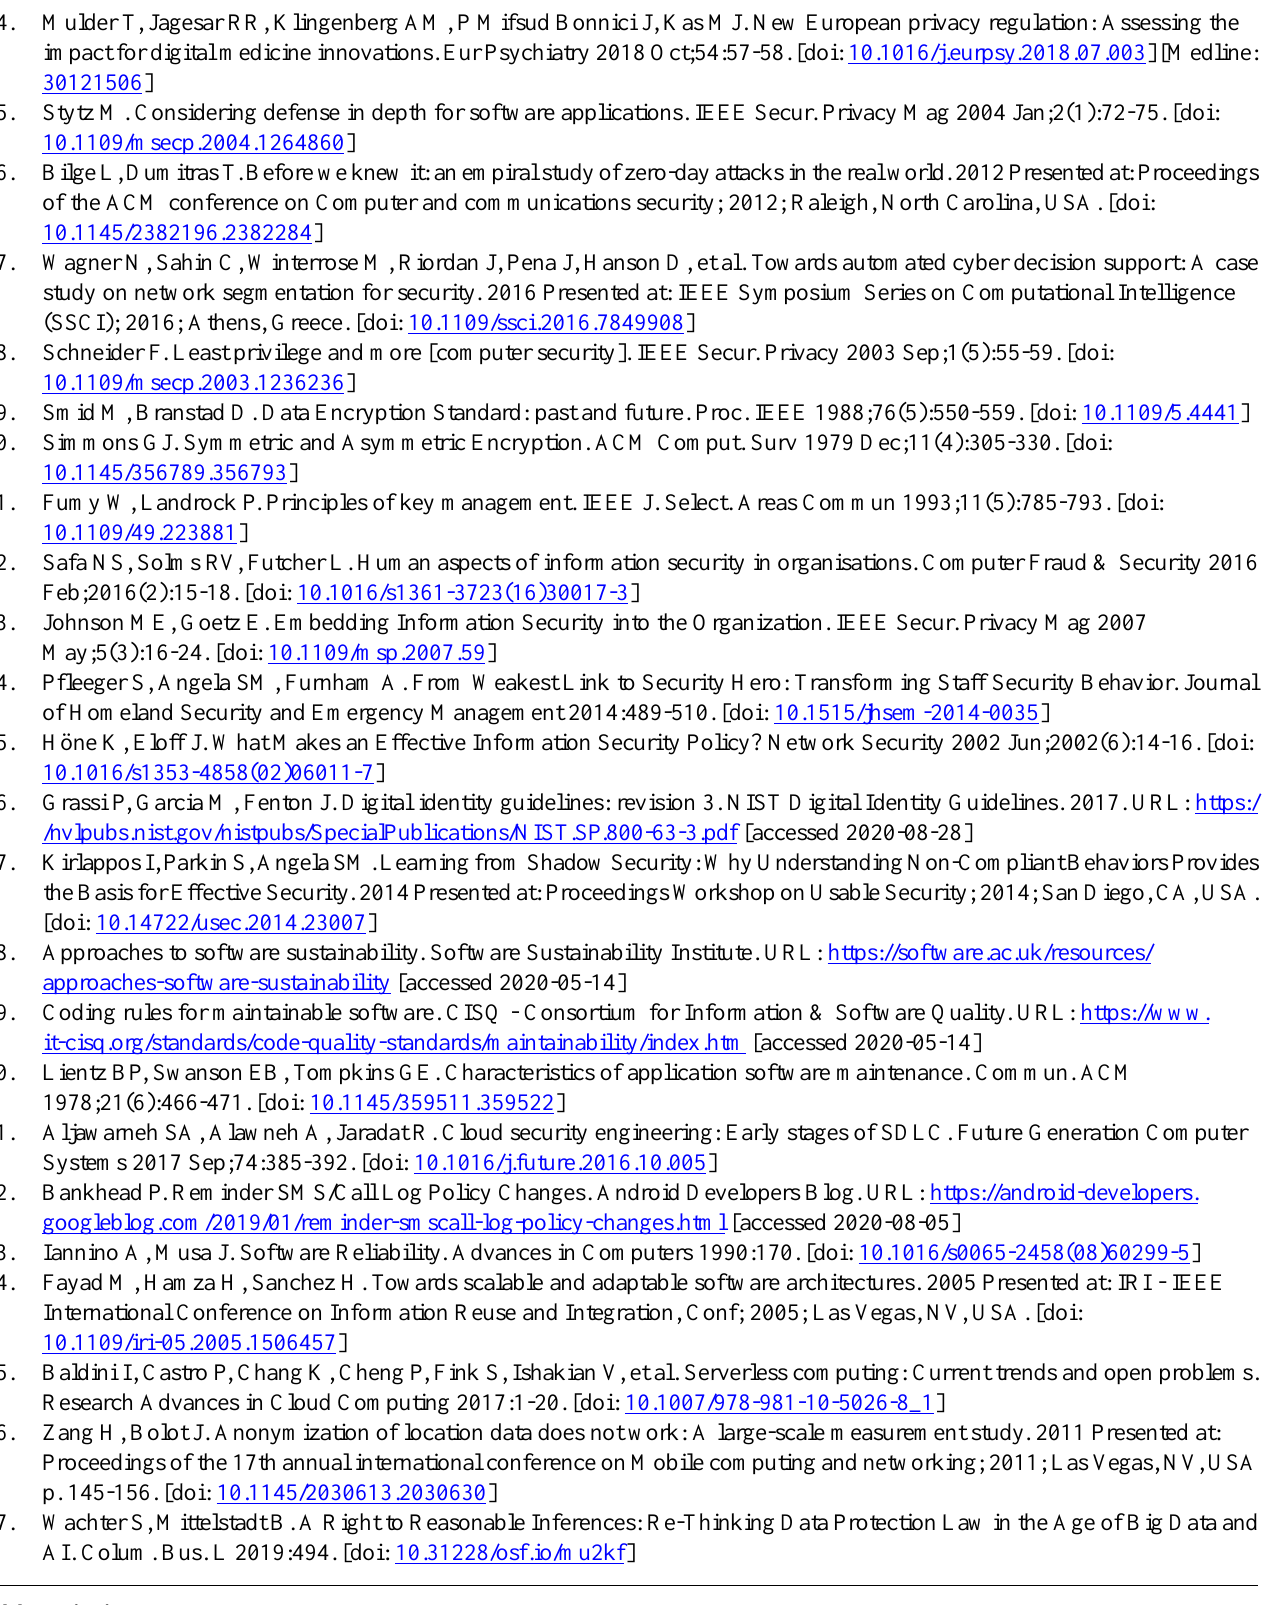
DPIA: Data Protection Impact Assessment GDPR: General Data Protection